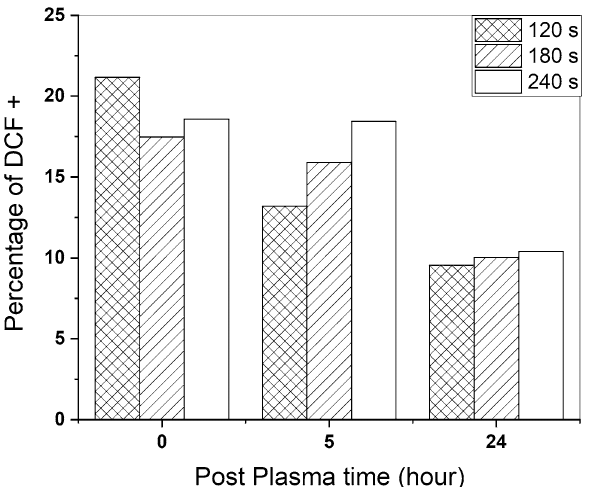
Figure 6. Intracellular RONS produced after CAP treatment and quantified by the H2DCF-DA indicator.